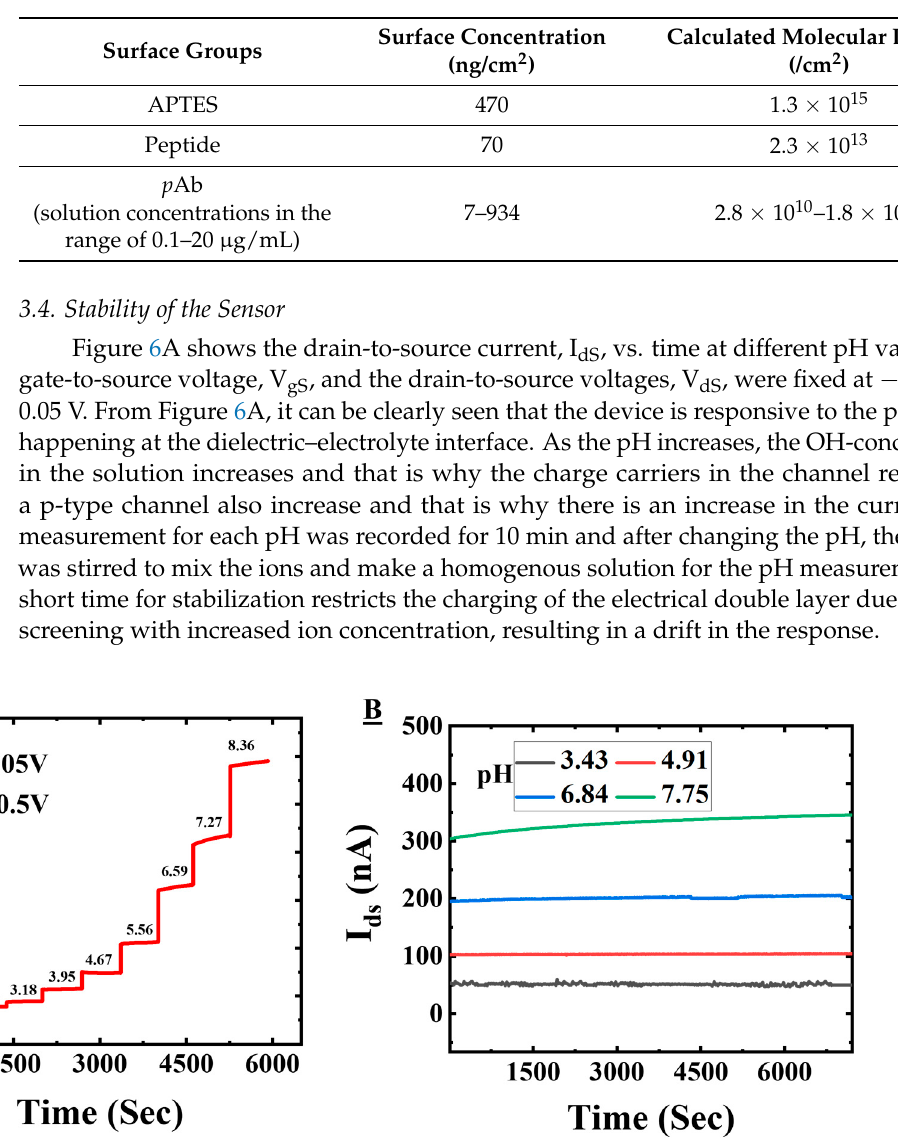
Table 1. Surface molecular densities with respect to the surface mass absorption.